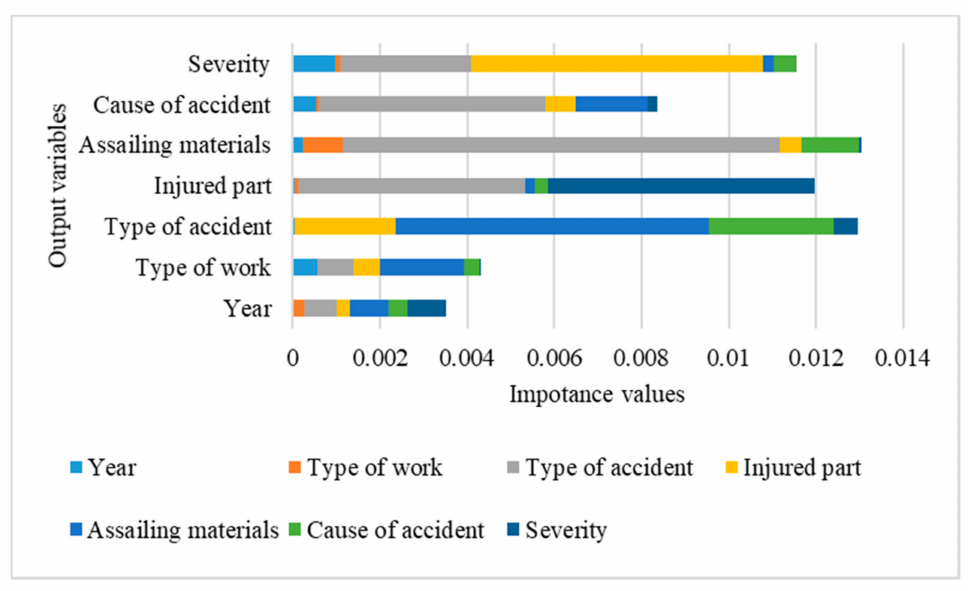
Figure 3. Contributions of input variables according to